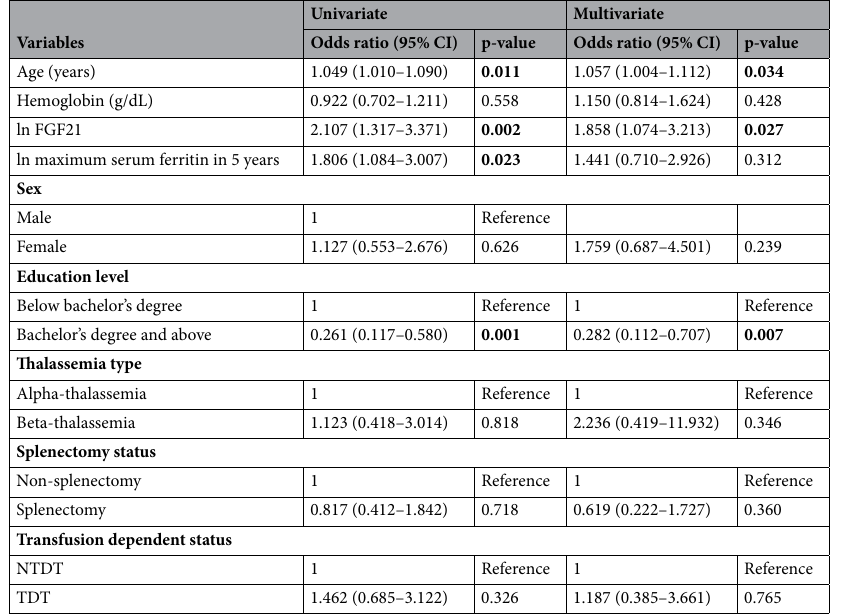
Table 3. Binary logistic regression analysis of association to determine the factors associated with mild cognitive impairment in thalassemia patients. Age, hemoglobin, ln FGF21, ln maximum serum ferritin in 5 years, sex, education level, thalassemia type, splenectomy status, and transfusion dependent status were used in binary logistic regression analysis. FGF21 fibroblast growth factor 21, NTDT non-transfusion dependent thalassemia, TDT transfusion dependent